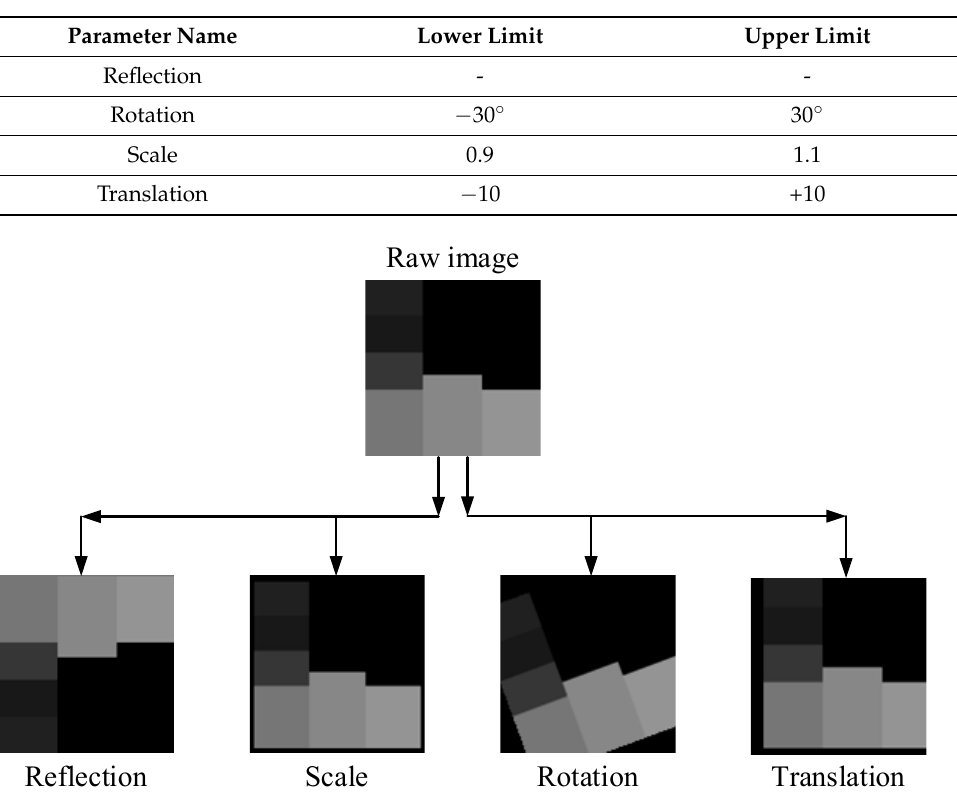
Figure 5. Data augmentation methodologies and sample augmented images. Table 2. Approaches to data augmentation’s lower and upper limitations.